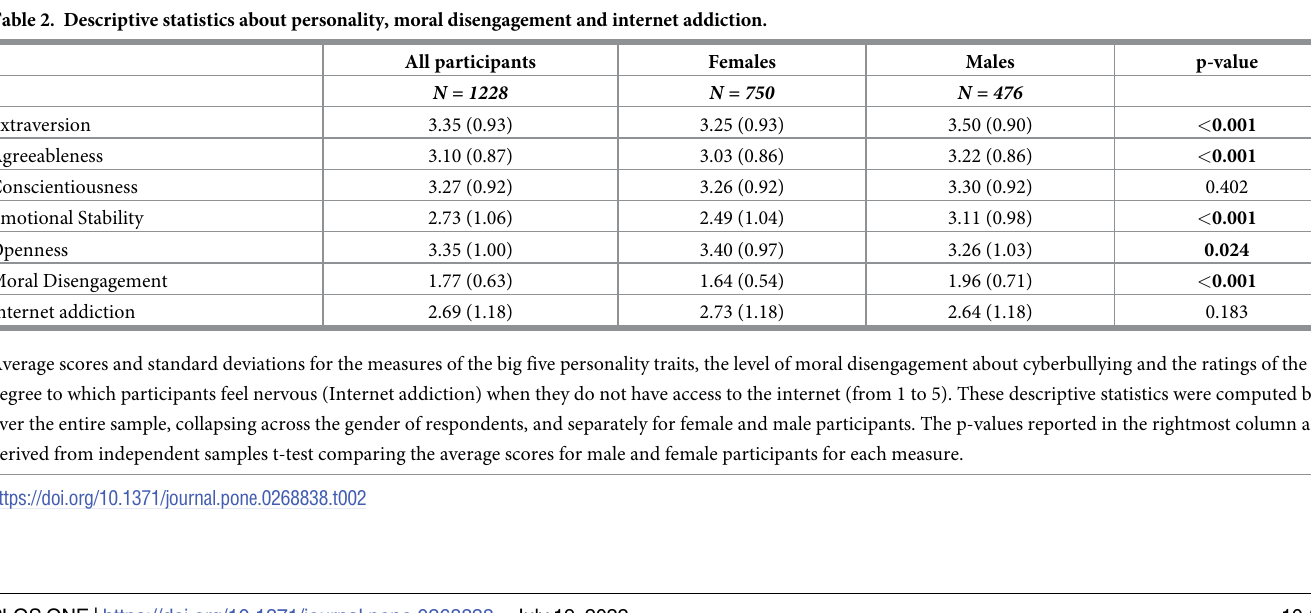
In Table 2 are reported the average scores for the measures of personality traits and moral dis- engagement in the sample, overall and by gender. A series of independent sample t-tests showed that girls were significantly less extravert and agreeable, they had less recourse to moral disengagement mechanisms and were less emotionally stable and open than boys. The average score on the question about feeling nervous without access to the internet is also reported in the bottom row (M = 2.69, SD = 1.18), and for this variable no significant differ- ences were found by gender and age group.